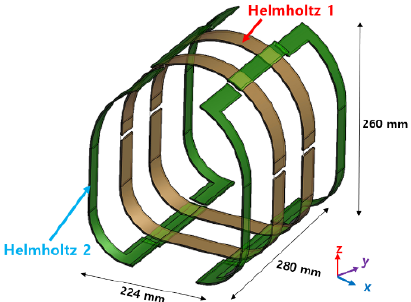
Figure 1. Geometry and dimensions of the numerically modeled head RF coil in a 0.3 Tesla open MRI system.